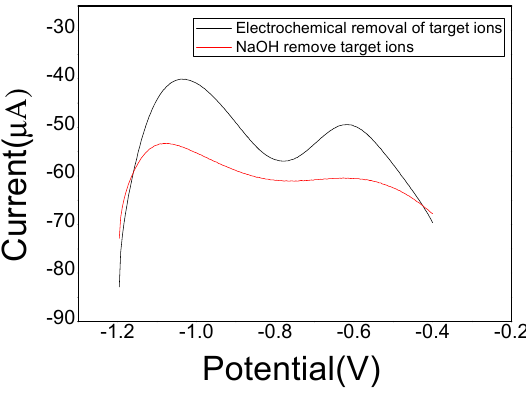
Figure 7. SWASV curves of different remove methods upon the 10 ng/mL Cd(II) standard solution.